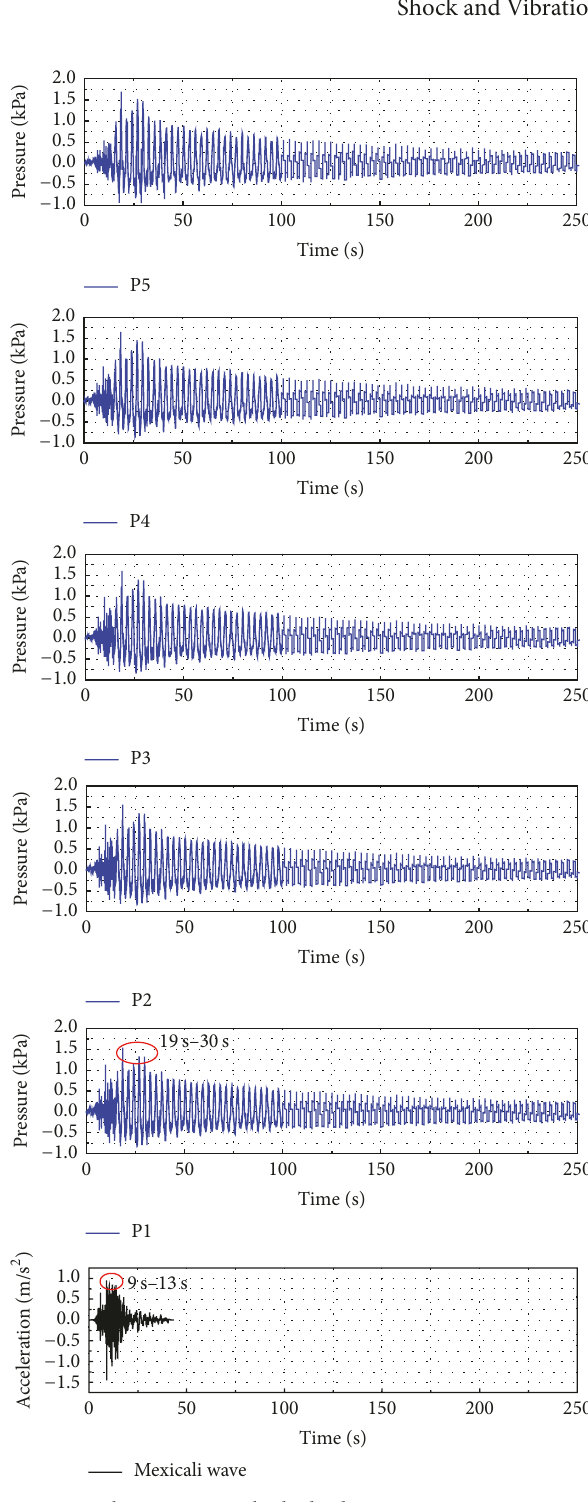
for the maximum hydrodynamic pressures obtained at the corresponding heights are listed in Table